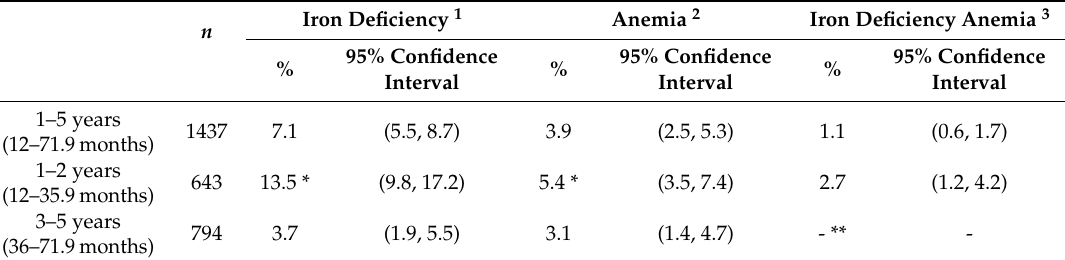
Table 1. Prevalence of Iron Deficiency, Anemia, and Iron Deficiency Anemia among Children 1–5 years in the United States, National Health and Nutrition Examination Survey (NHANES) 2007–2010.